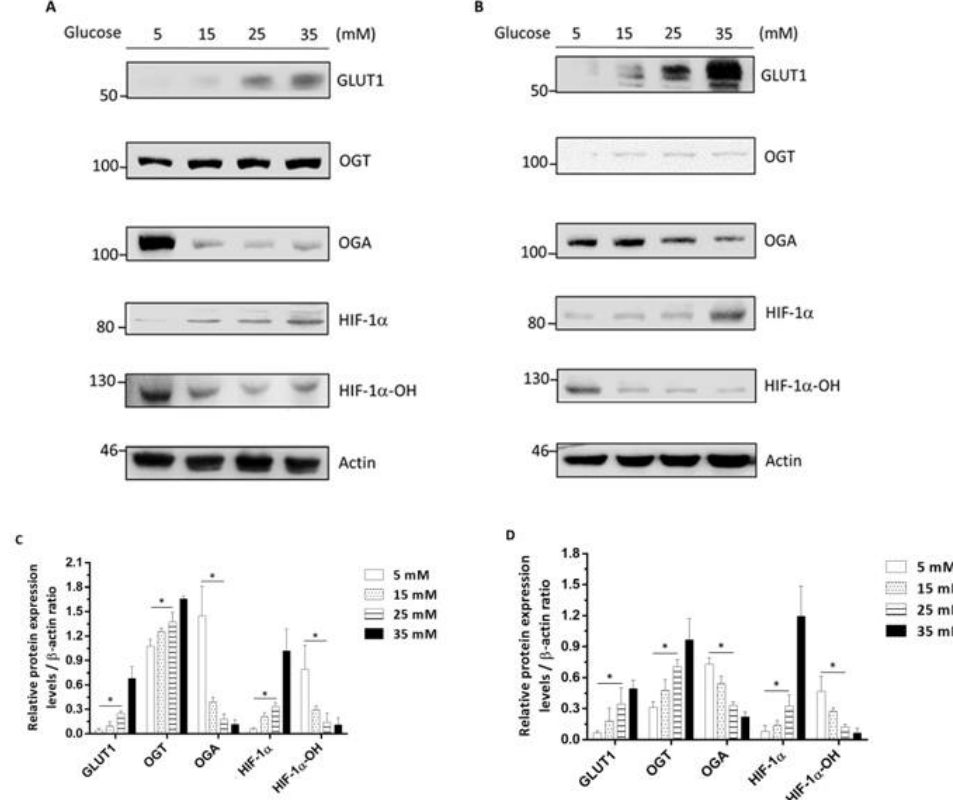
Figure 2. High glucose activates the GLUT1-OGT-HIF-1α signaling pathway leading to HIF-1α expression. HCT116 ( A ) and SW480 ( B ) cells were treated with 5, 15, 25, and 35 mM. After 48 h the cytoplasmic extrusion mass was collected and the endogenous protein levels of GLUT1, OGT, OGA, HIF-1α-OH, HIF-1α, and β-actin were evaluated using antibodies and Western blotting. Relative protein expressions in HCT116 ( C ) and SW480 ( D ) cells are shown. Data are presented as mean ± SD ( n = 3; * p < 0.05).